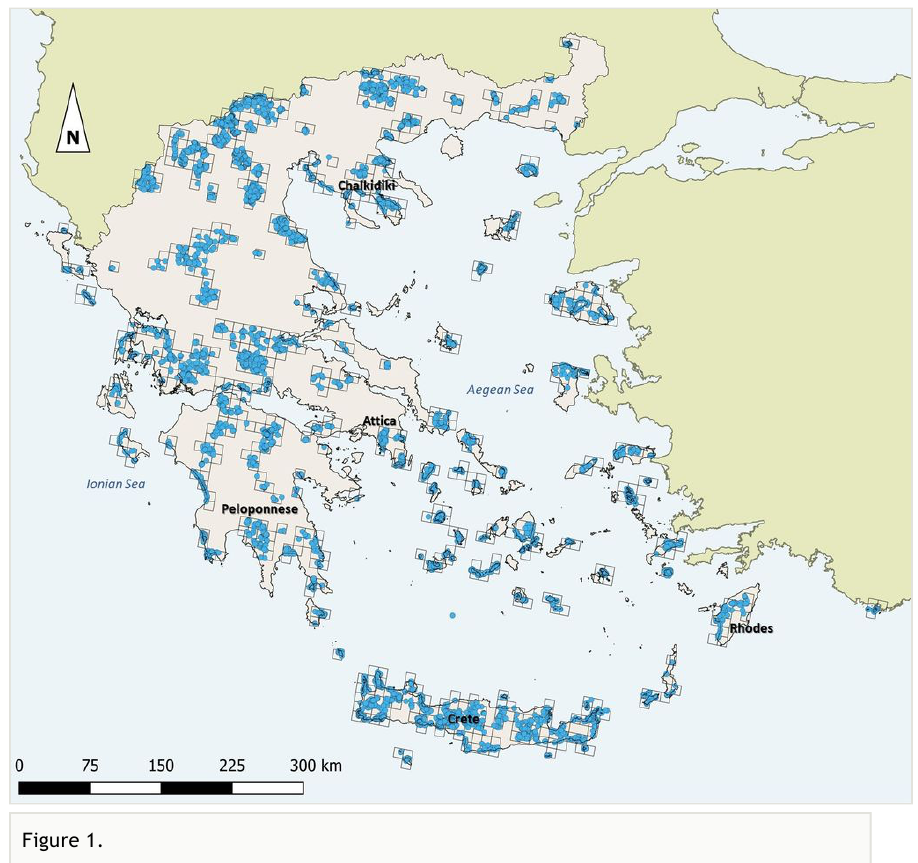
Figure 1. Sample plots’ locations (blue dots) used for mapping and assessment of the ecosystem condition. This dataset derives from the monitoring protocols collected for the surveillance and conservation status assessment of habitat types in Greece (Hellenic Ministry of Environment and Energy